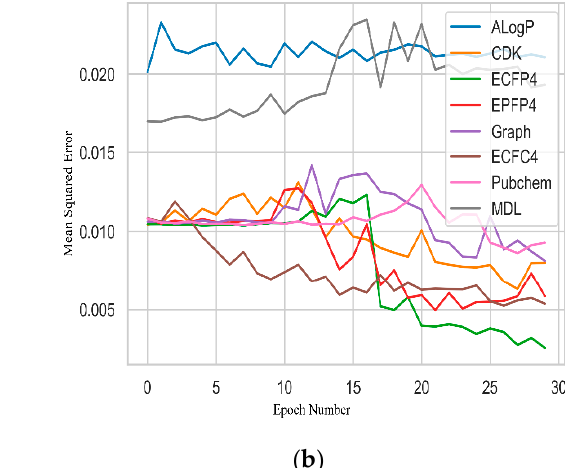
Figure 4. Prediction accuracy values of the CNN model for the eight fingerprint representatives using the violin-plot charts.